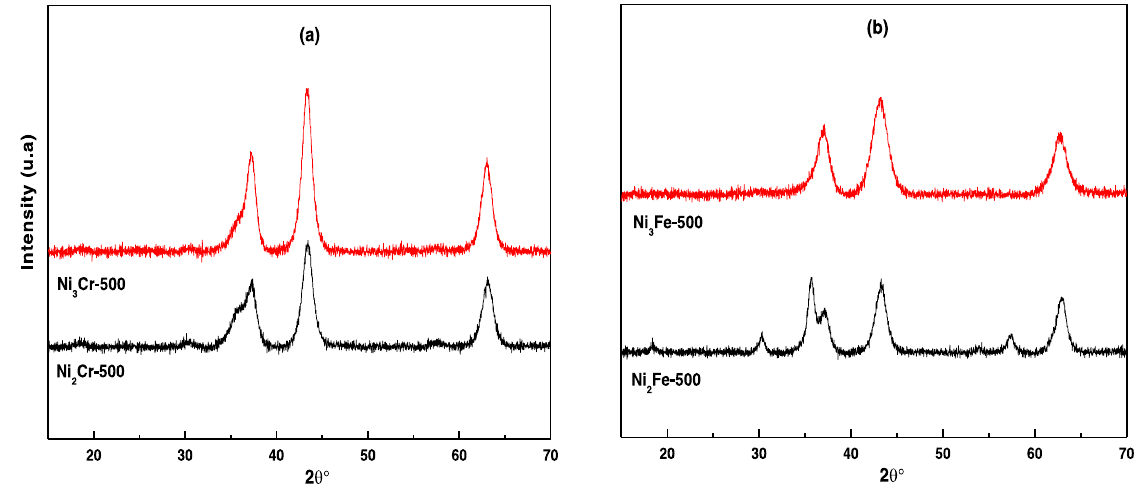
Figure 6. XRD patterns of Ni R Cr-500 ( a ) and Ni R Fe-500 ( b )